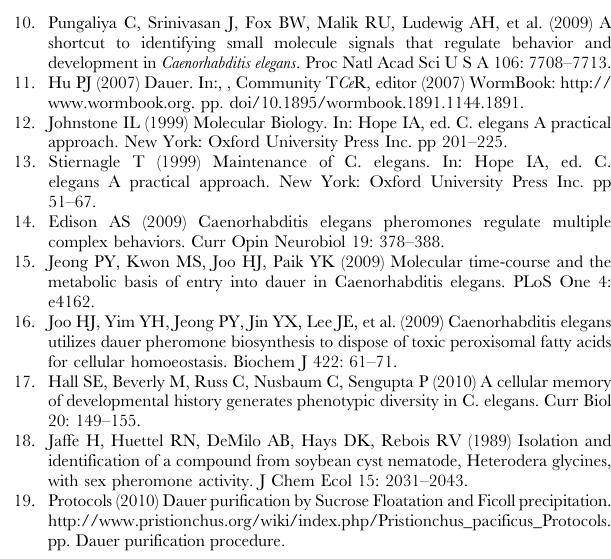
Figure S2 Ascaroside concentrations in WW samples using M9 buffer or Water. Ascarosides collected from